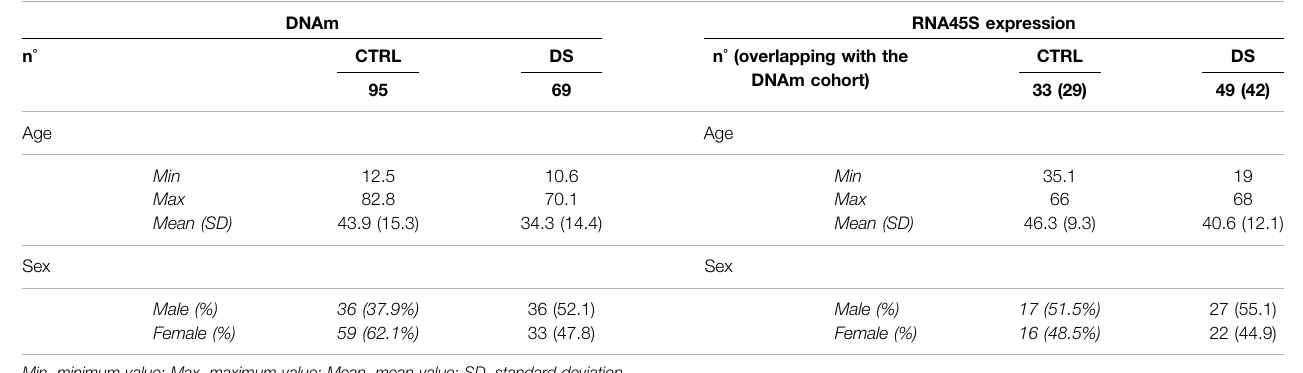
Frontiers in Genetics |